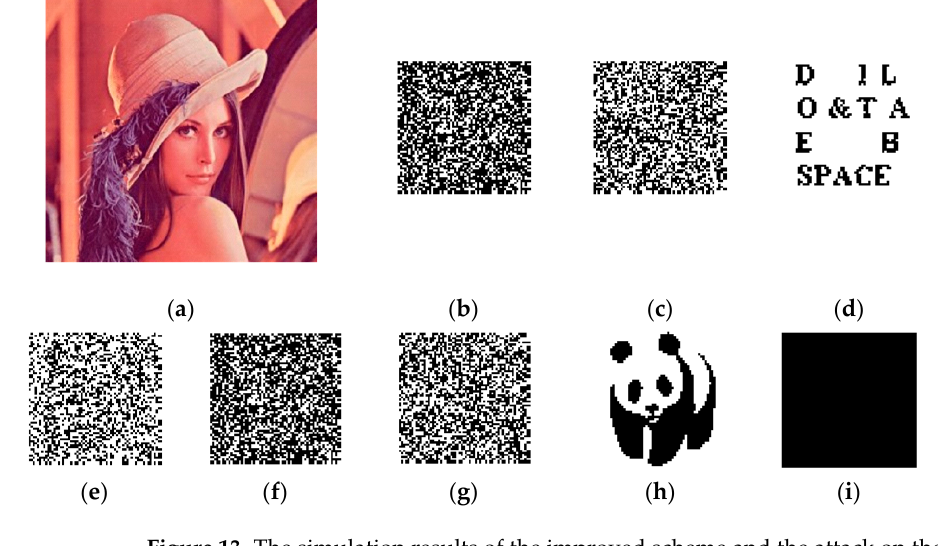
Figure 13. The simulation results of the improved scheme and the a tt ack on the improved scheme